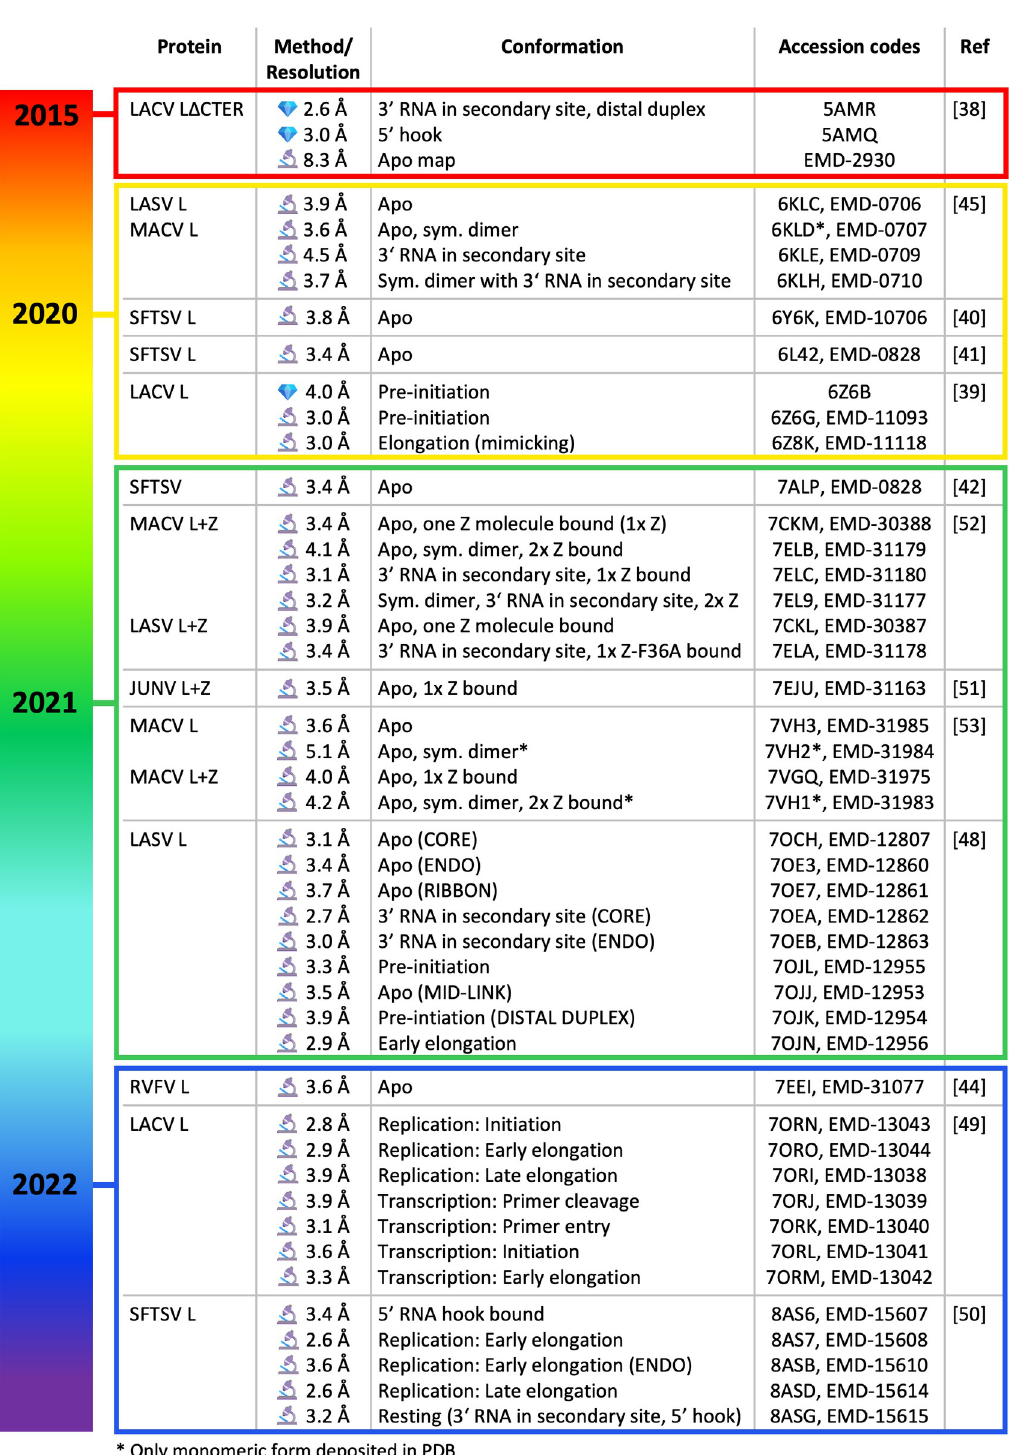
PLOS Pathogens| https://doi.org/10.1371/journal.ppat.1011060 January12,